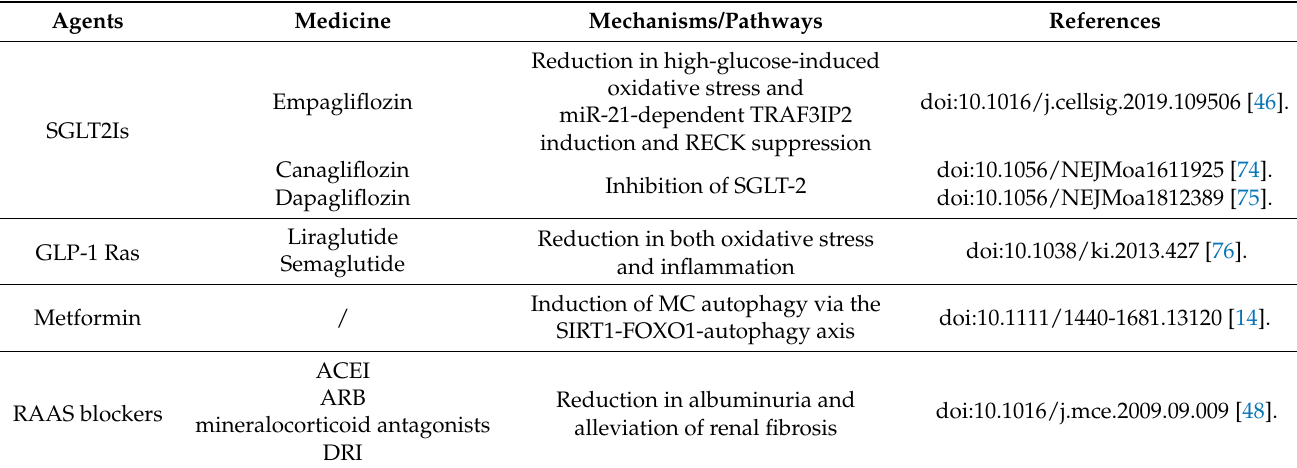
Table 1. The evidence-based management of